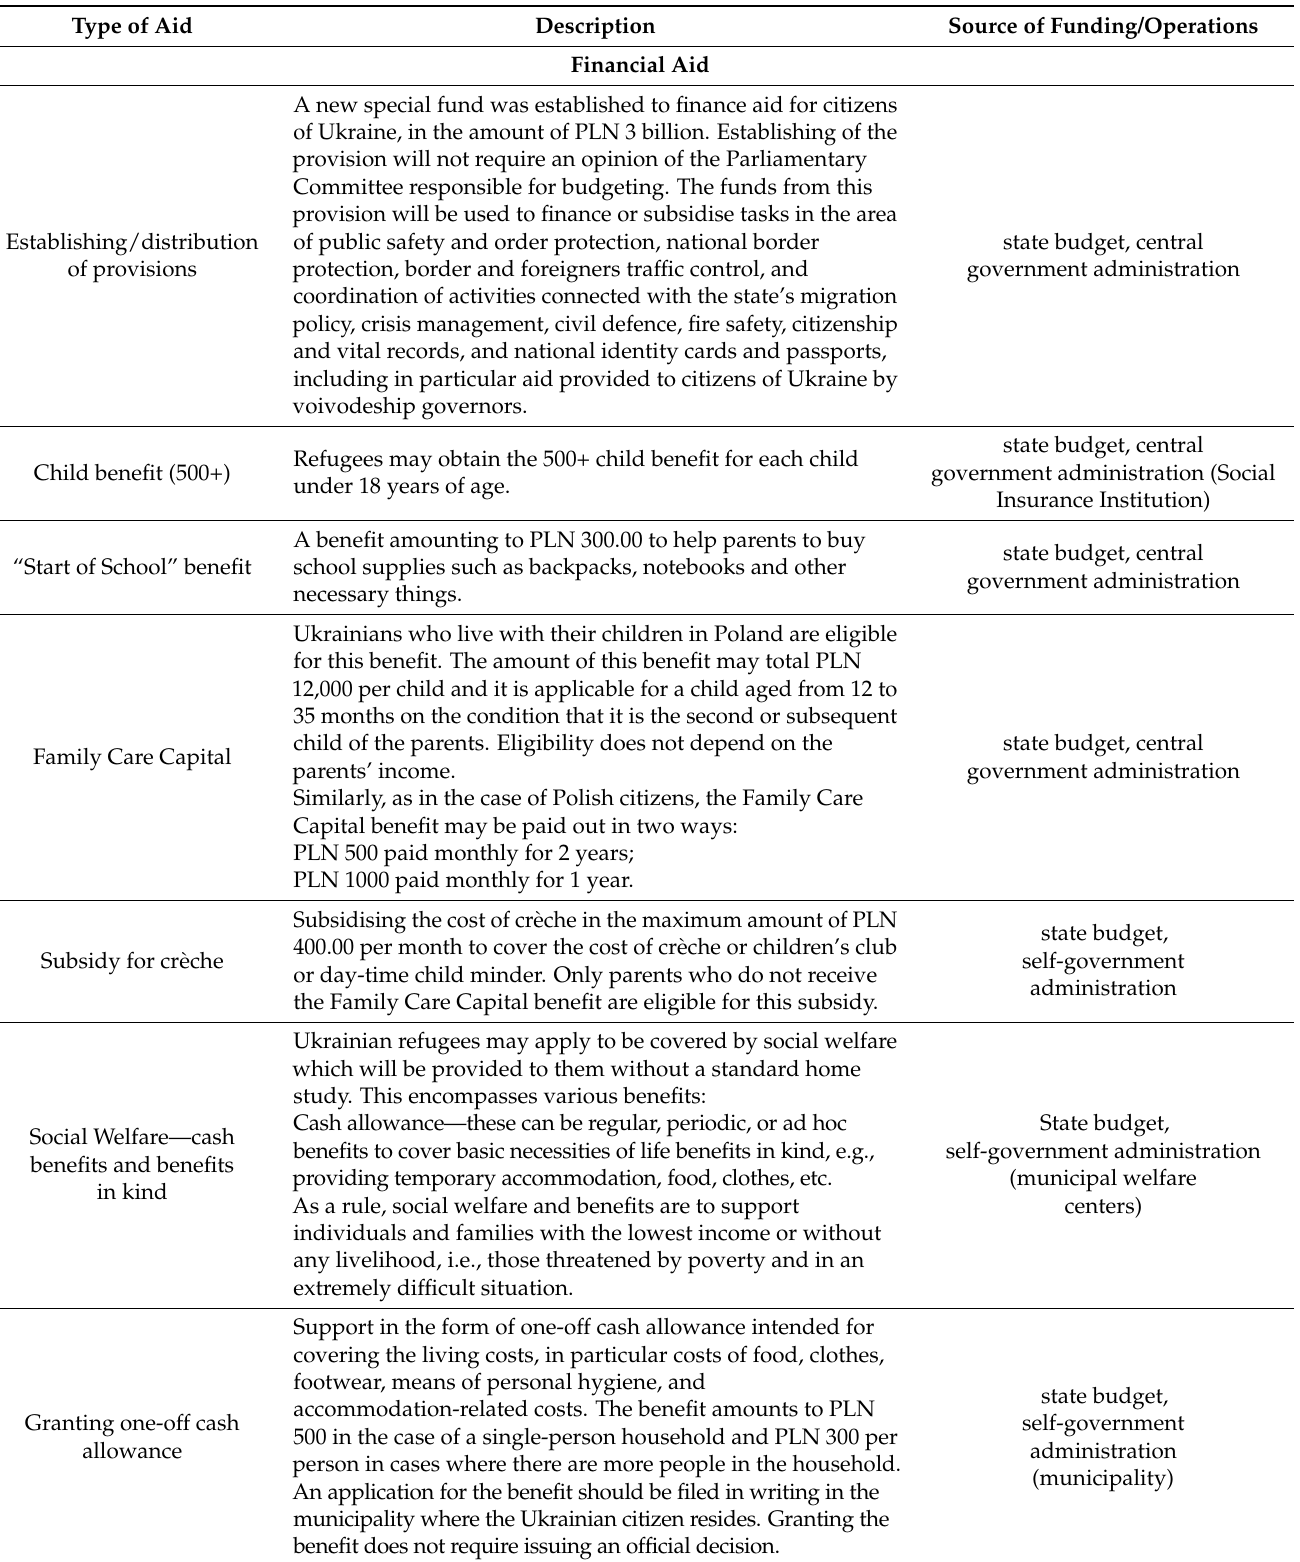
Table 1. Types of aid for which Ukrainian refugees are eligible grouped by